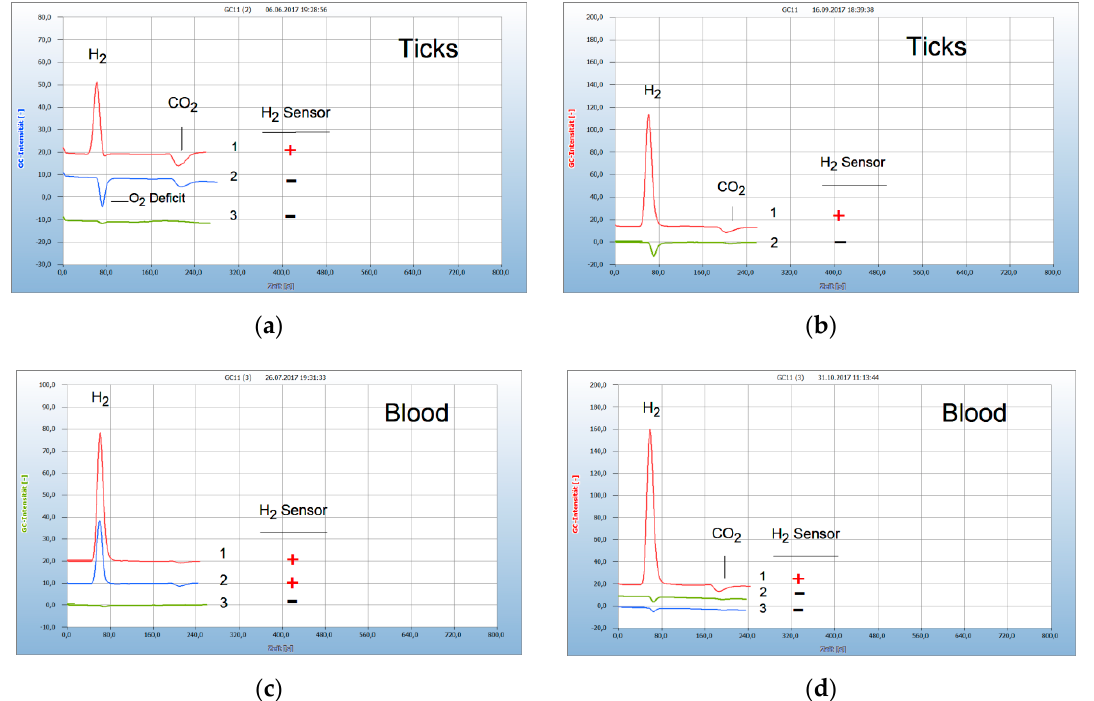
Figure 4. Infected ticks and transfer to blood by in vitro tests. Gas chromatography: column Silicagel, carrier gas ambient air, 6 mL headspace vials, 2.5 mL culture broth. H 2 emission ( + ), no H 2 emission ( − ). Blank: cotton bud in culture broth. ( a ) 1 = tick, infected by Borrelia+ ( + ), 2 = tick, infected by aerobes ( − ), 3 = blank ( − ). ( b ) 1 = tick, infected by Borrelia+ ( + ), 2 = tick, not infected ( − ). ( c ) 1 = blood, infected by Borrelia+ ( + ), 2 = tick, infected and responsible for bacteria transfer ( + ), 3 = blank ( − ). ( d ) 1 = blood, infected by Borrelia+ ( + ), 2 = healthy blood ( − ), 3 = blank ( − ).